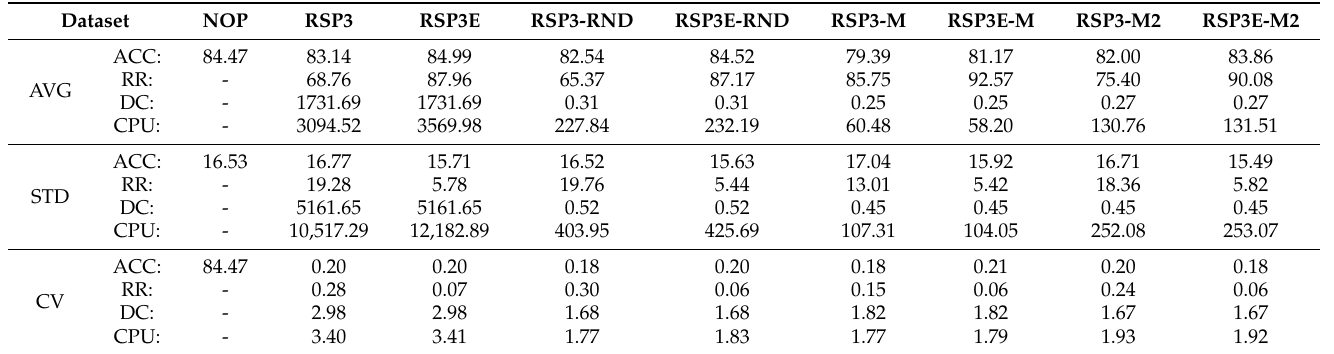
Table 3. Statistics of experimental measurements (Average (AVG), Standard Deviation (STDEV), Coefficient of Variation